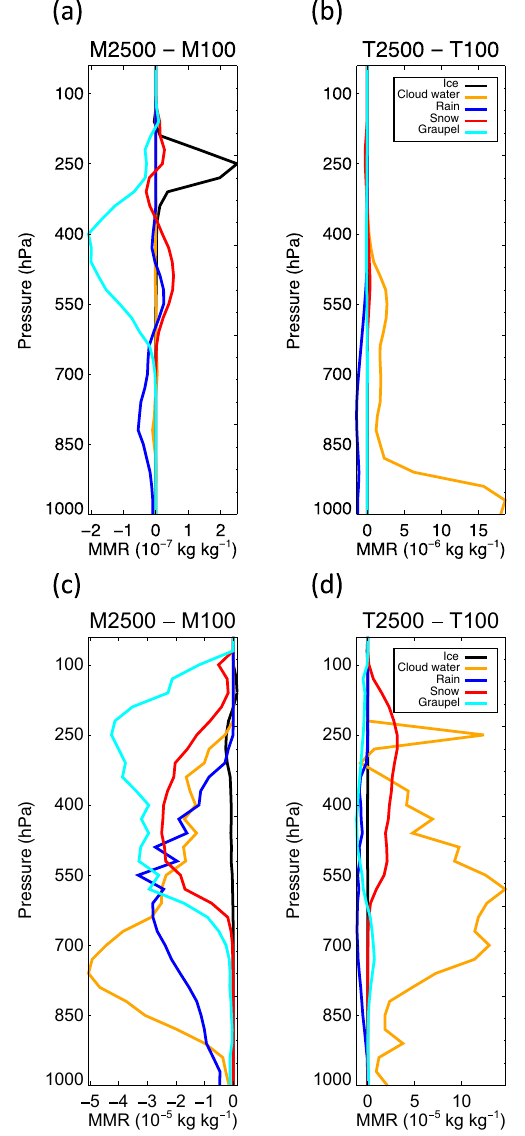
Figure 7. Congo case: difference in the mean hydrometeor mix- ing ratio profiles under polluted and pristine conditions averaged over the period 1–10 August 2007. (a) CONGO-M2500 cloudy column domain mean minus CONGO-M100 domain-mean, (b) CONGO-T2500 domain-mean minus CONGO-T100 domain mean, (c) CONGO-M2500 mean over all condensed points of each hy- drometeor class minus CONGO-M100 mean over all condensed points and (d) ONGO-T2500 mean over all condensed points mi- nus CONGO-T100 mean over all condensed